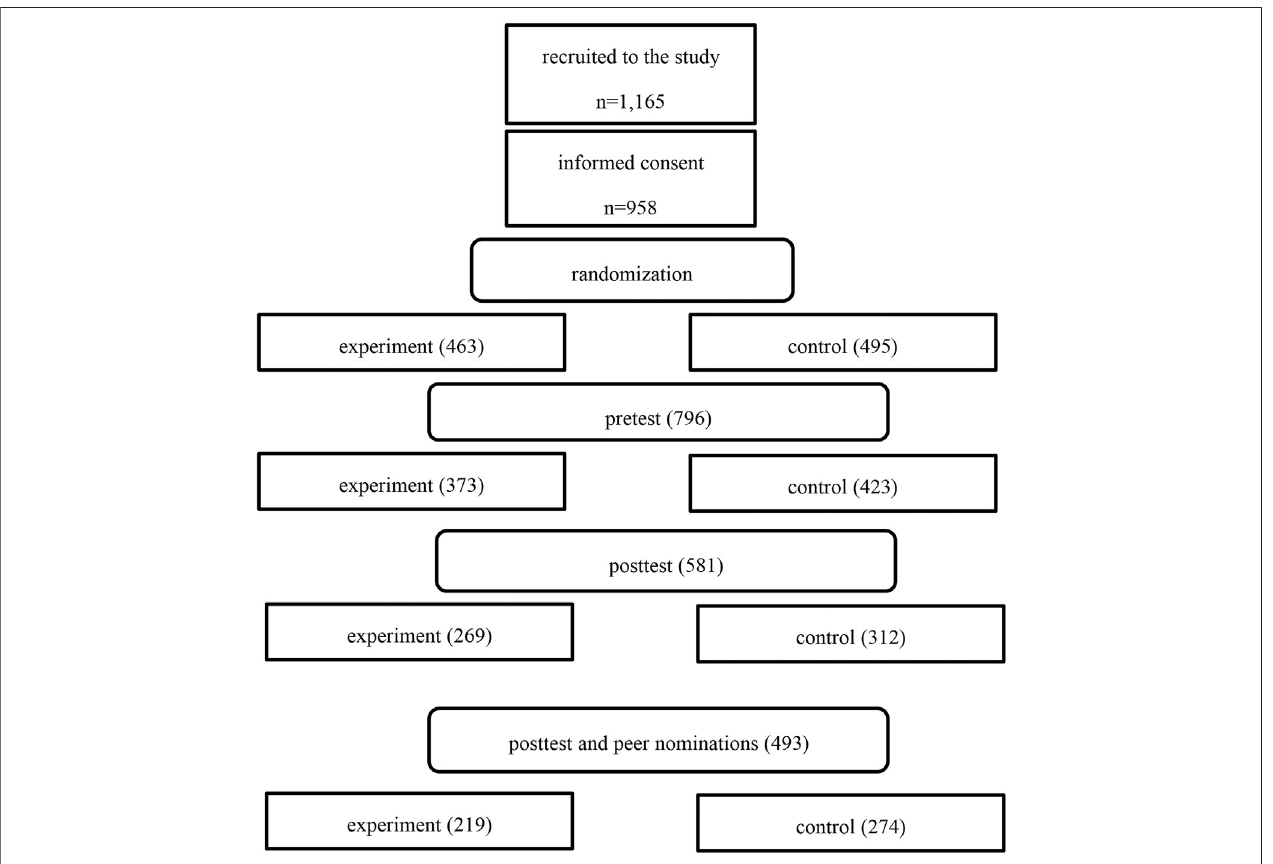
FIGURE 1 | Flow chart for participants included in data collection and data analysis.